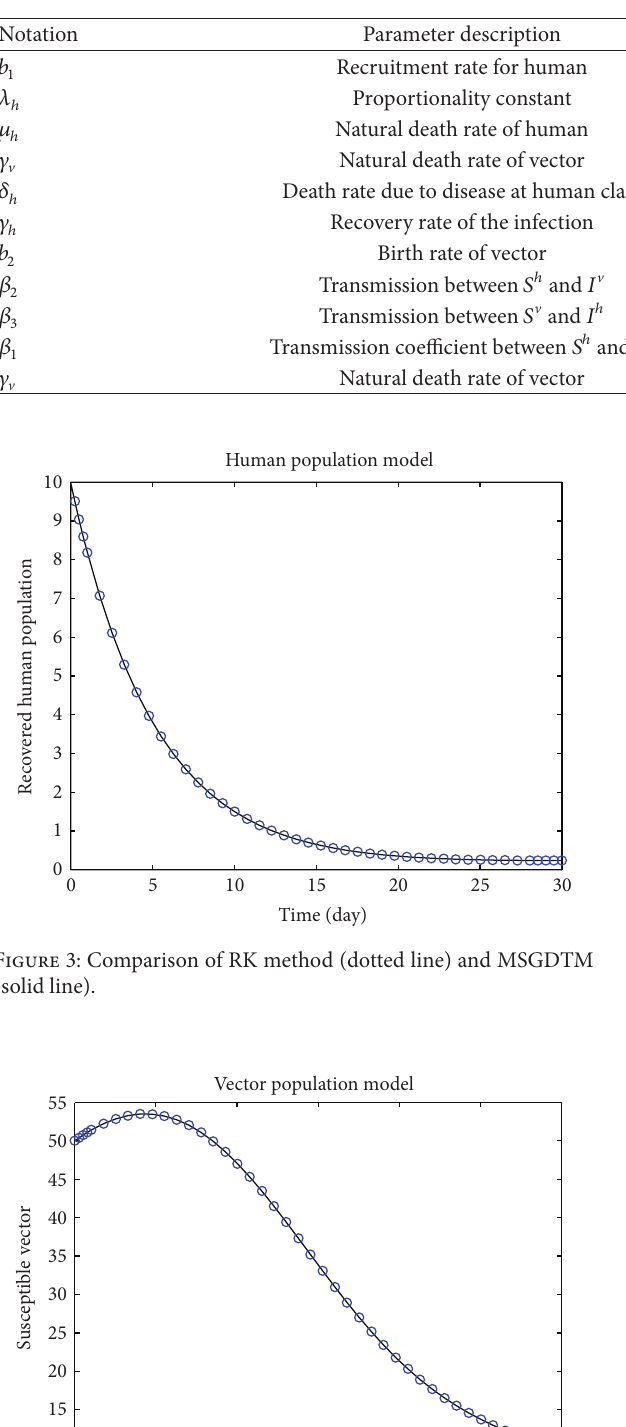
Table 2: Parameter values used in the numerical simulations of the optimal control.